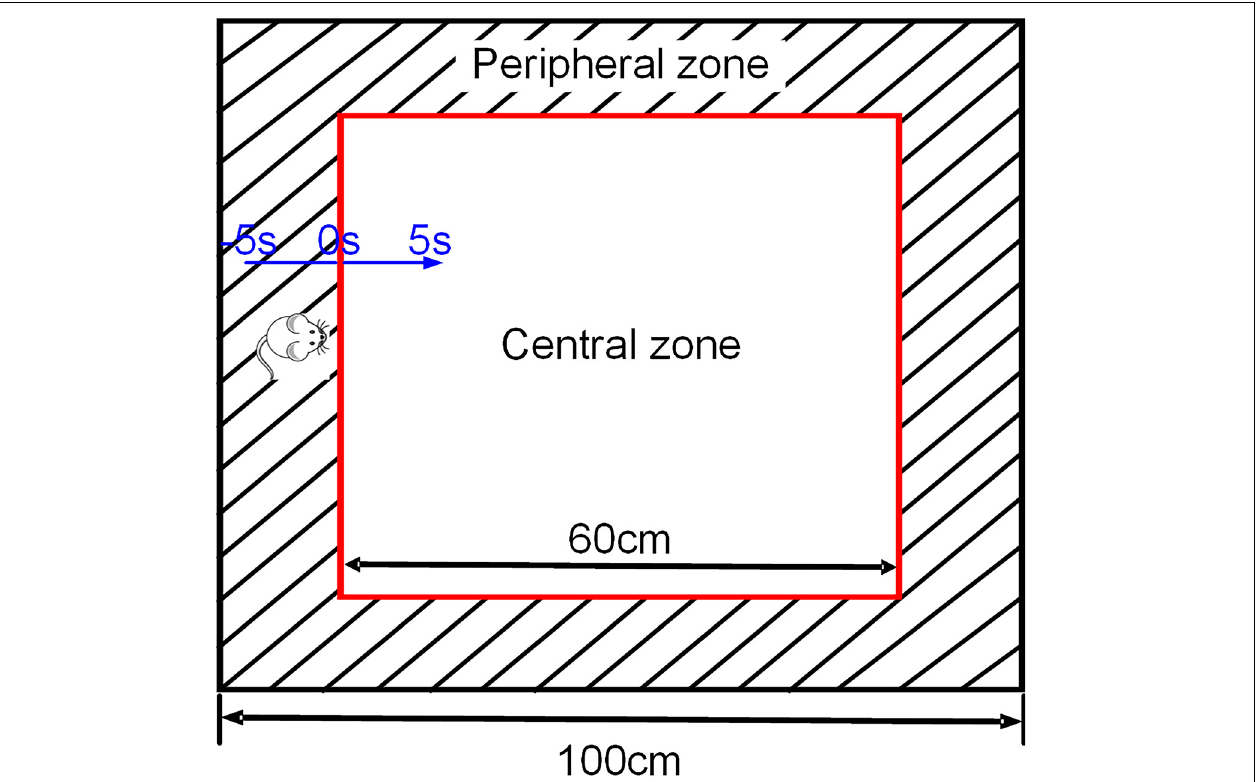
FIGURE 1 | Schematic representation of exploratory behavior in OFT. The black square refers to the four walls of the open field, and the red square in the middle is the central area (only for video analysis). The area between the two squares is the peripheral zone. The blue one-way arrow indicates that the rat moves from the peripheral to the central zone, and the black two-way arrow is used to describe the size of the open